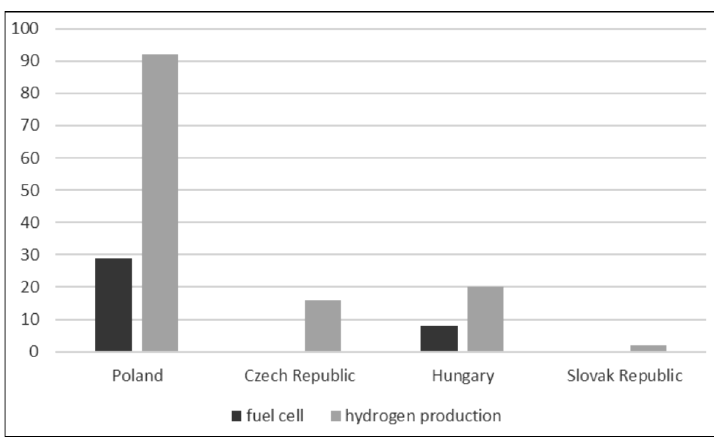
Activity of patents in technology of fuel cells and hydrogen production in the V4